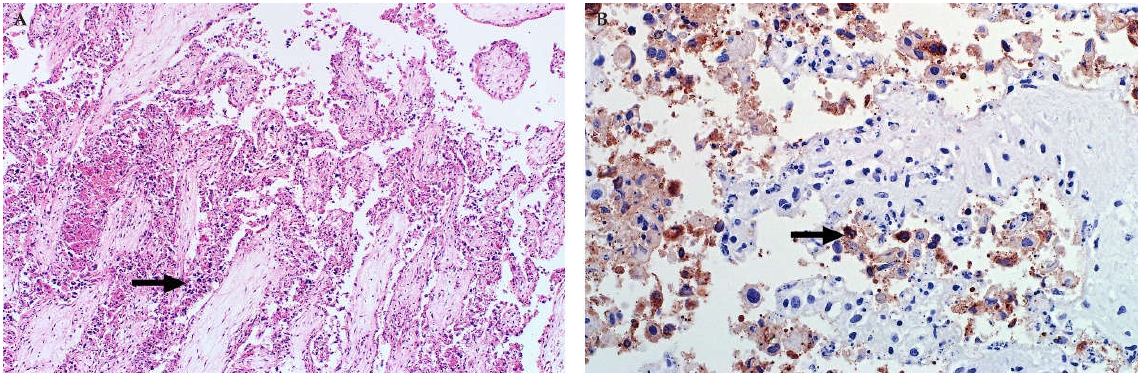
Figure 15. Placenta of RVFV-infected sheep. ( A ) Diffuse necrosis of trophoblasts with cellular debris (arrow) between the villi (H&E stain), mag 100×. ( B ) Immunolabelling in trophoblasts and cellular debris (arrow) in the cotyledonary chorioallantois (NovaRed IHC as detailed in Figure 5), mag 400×.